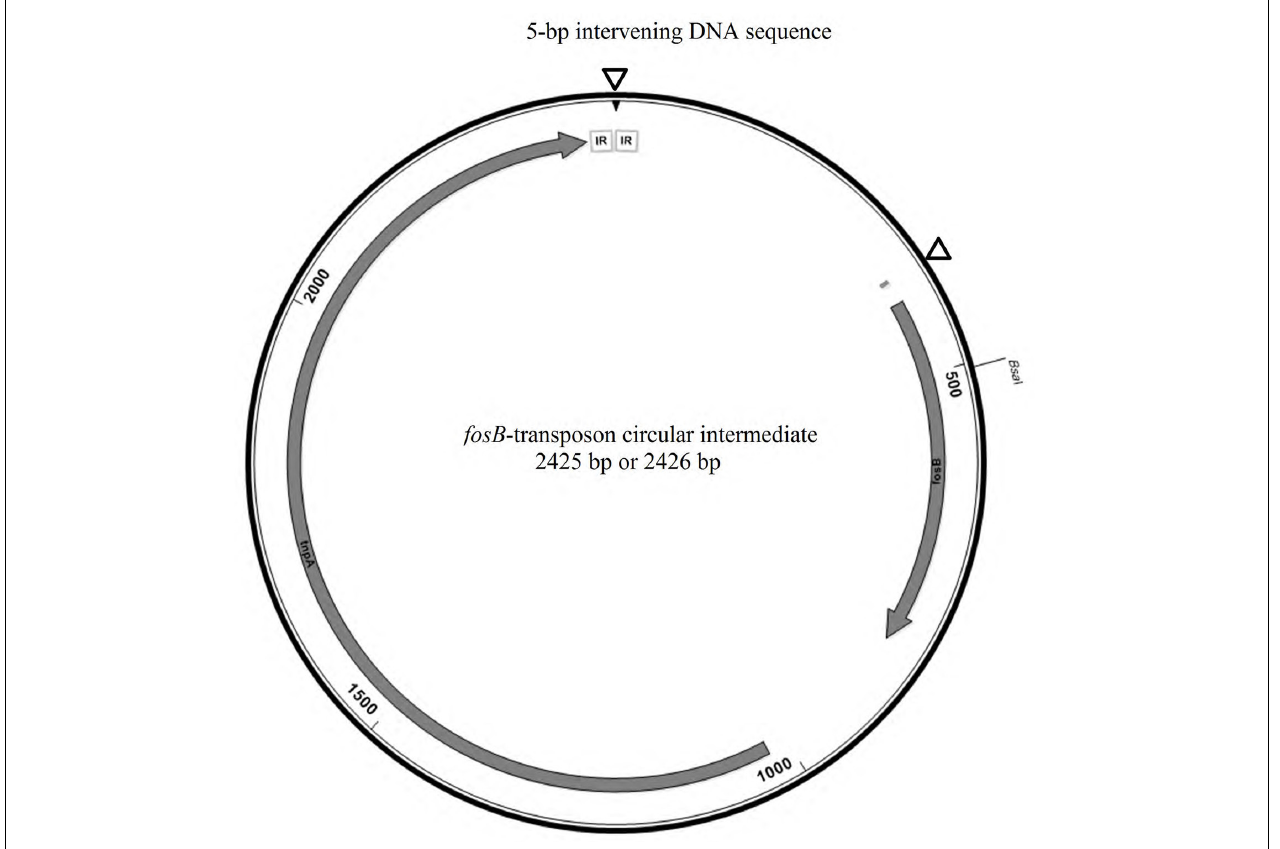
FIGURE 4 | The schematic map of fosB -transposon circular intermediate. The polymorphism regions were indicated by triangles. The two IRs sequence was framed in gray.